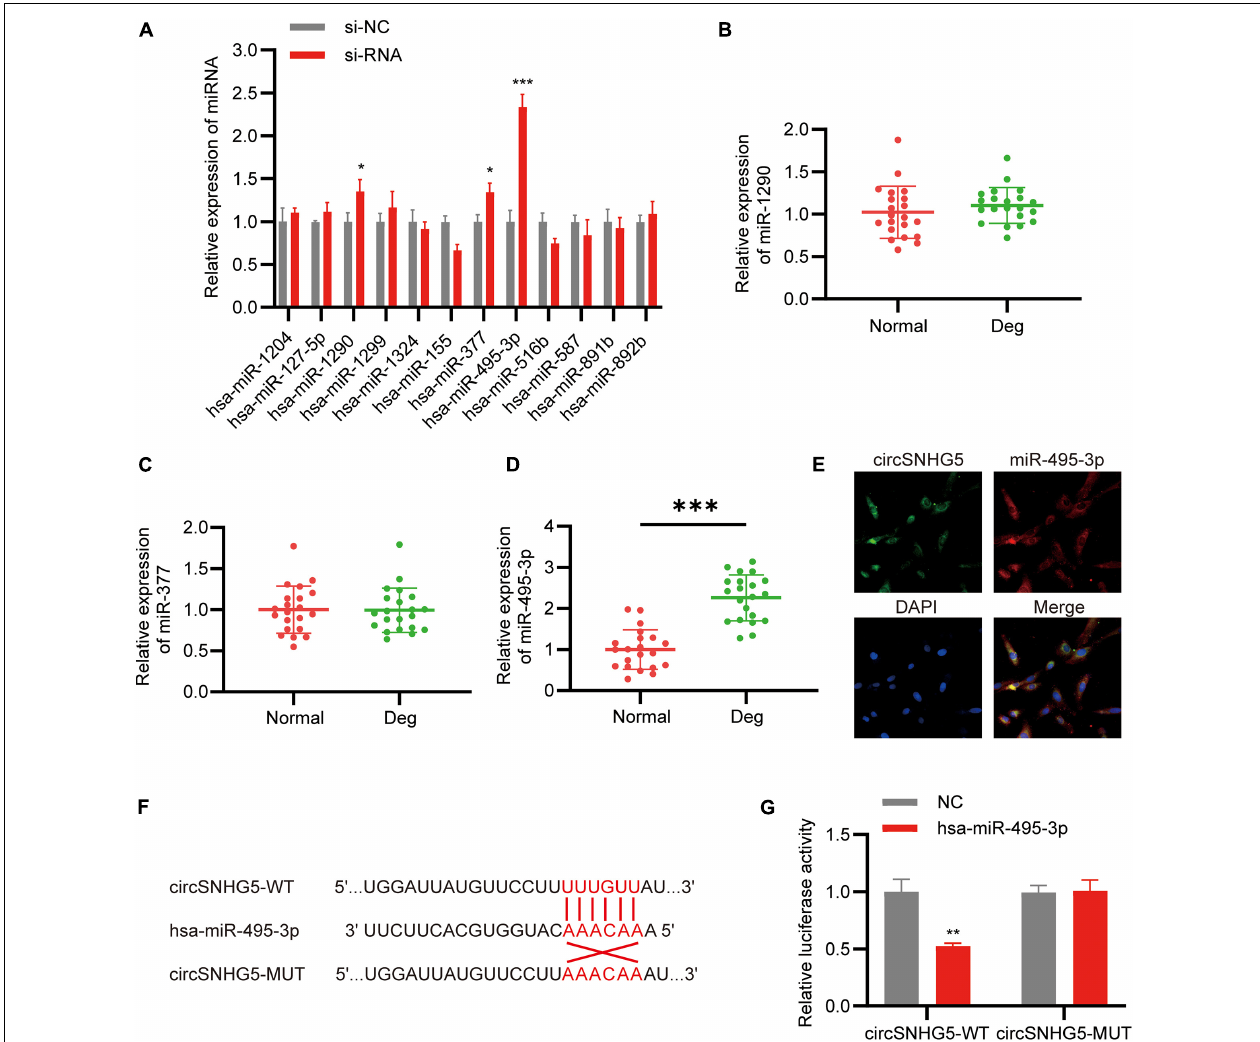
FIGURE 3 | CircSNHG5 serves as a sponge for the miR-495-3p to inhibit its expression. (A) The expression of predicted miRNAs in chondrocytes after transfection with siRNA (* P < 0.05, *** P < 0.001). (B–D) qRT-PCR analysis confirmed the upregulated miRNAs in different CEP tissues of 21 patients and 21 control samples (*** P < 0.001). (E) RNA FISH detection of the subcellular localizations of circSNHG5 and miR-495-3p. Both molecules were co-localized and both were cytoplasmic. miR-495-3p probes were labeled with Cy3, whereas circSNHG5 probes were tagged with Alexa fluor 488. Scale bar, 20 µ m. (F) The binding region of miR-495-3p in circSNHG5 3 (cid:48) UTR is shown. (G) Luciferase reporter analysis of either wild-type or mutant circSNHG5 3 (cid:48) -UTR activity. miR-495-3p was co-transfected with the wild-type or mutant vector. The presented values are the mean ± SEM of three different preparations (** P <